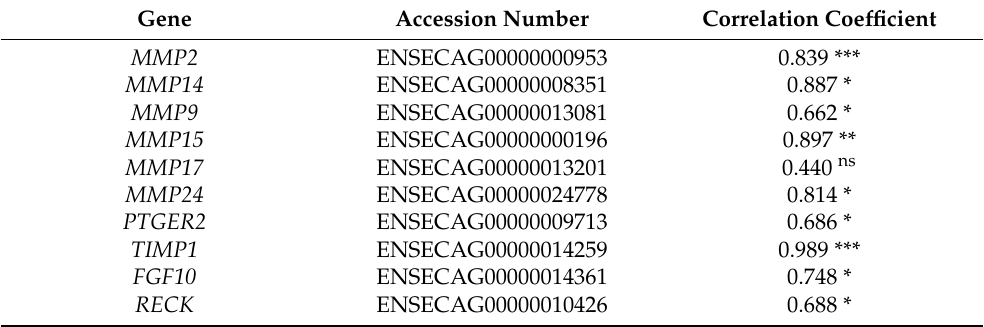
Figure 4. Regulation of actin cytoskeleton pathway (ecb04810) modifications following two strategies of sarcoid-dependent neoplastic transformation triggered either by BPV-E4 or by BPV-E1^E4 transgenes. The red squares denote genes modified by BPV-E4 insert, while the blue circles indicate BPV-E1^E4 transgene-induced modifications; arrows present molecular interaction or relation, while dotted arrows show indirect link or unknown reaction. Table 5. The correlation coefficients and their corresponding p -value for qPCR